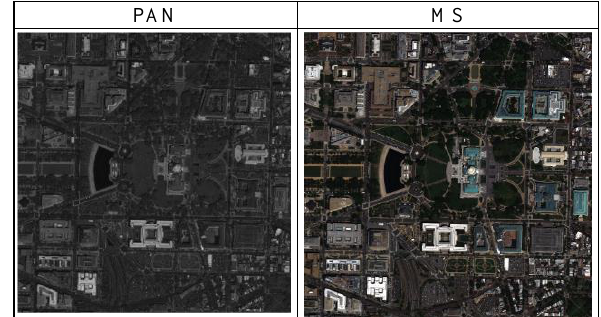
Figure 2. Data set 1, Washington DC-1 image set.